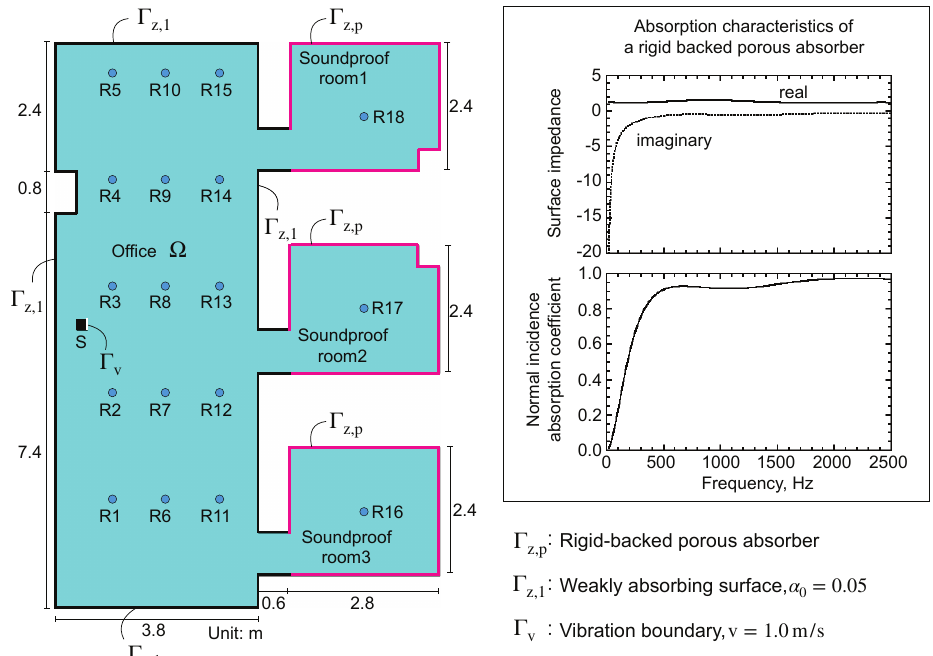
Figure 8. Coupled room model including a vibration boundary, with impedance boundaries of a reflecting surface and a rigid-backed porous absorber: S, R respectively represent the sound source and